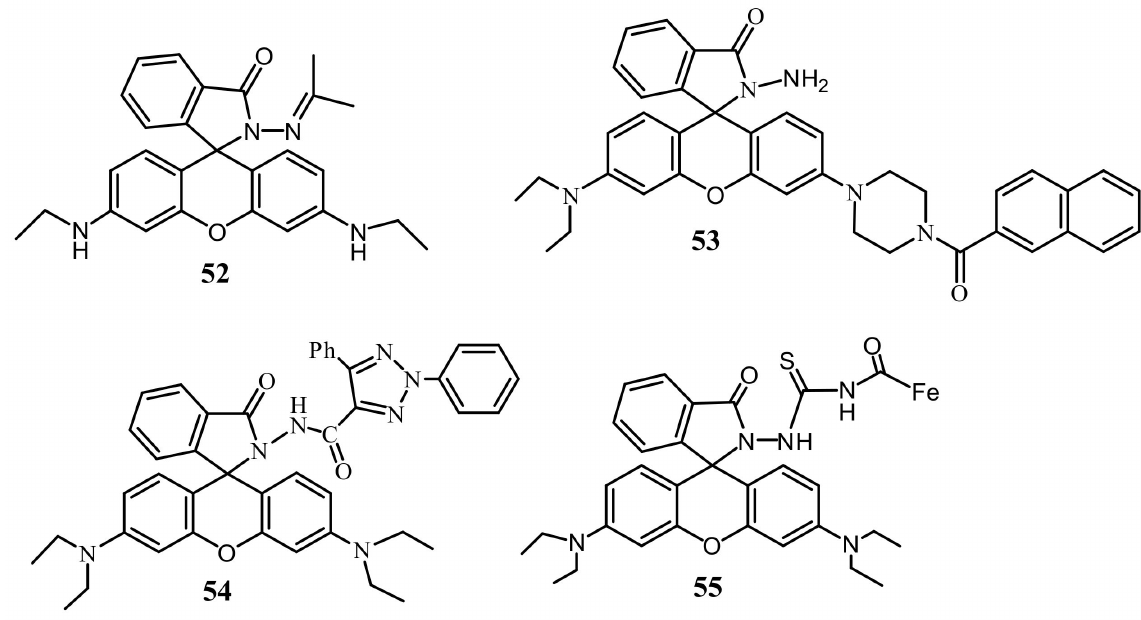
Figure 18. Molecular structures of the sensors 52 to 55